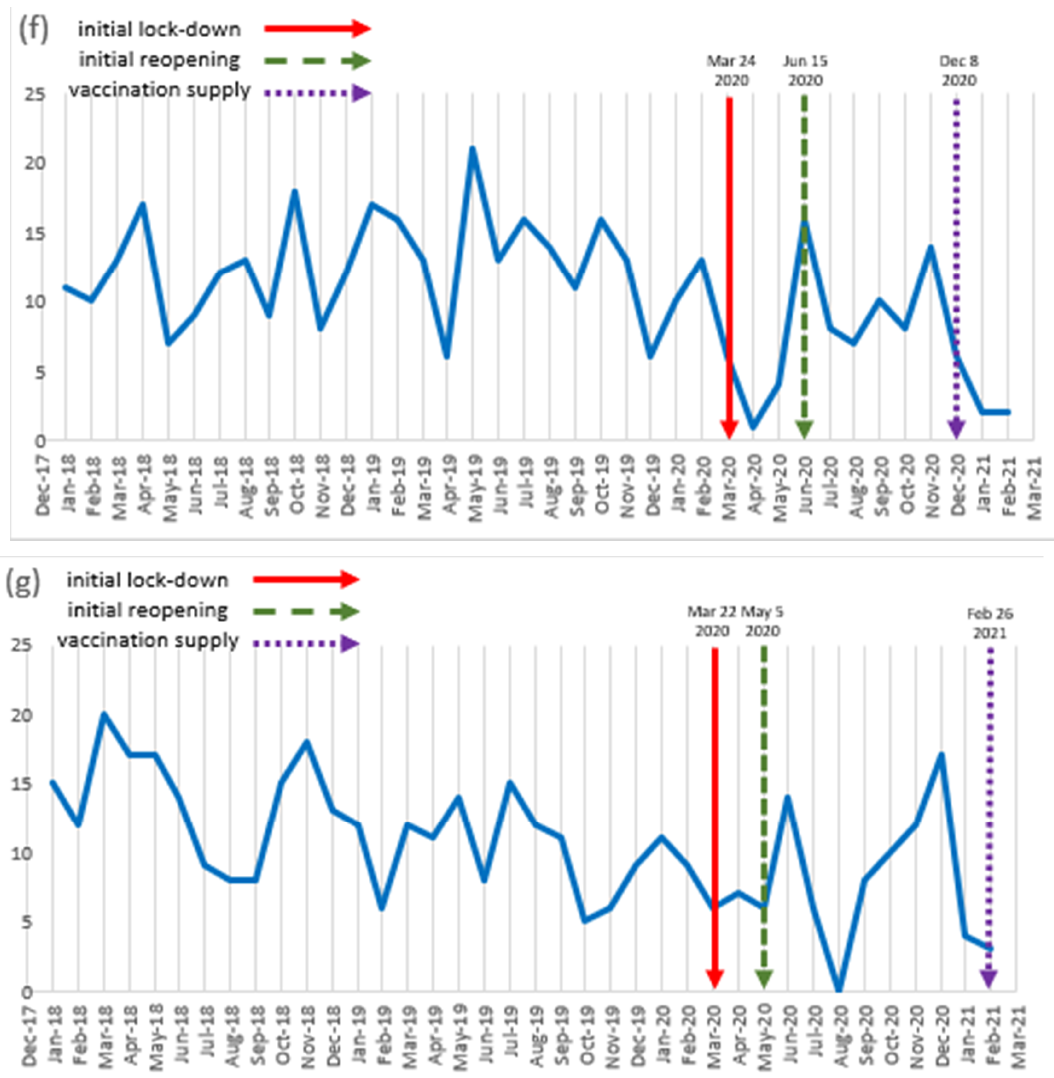
Figure 3. Monthly trends in the commencement of new oncology trials according to countries from 2018 to 2020. ( a ) United States; ( b ) China; ( c ) France; ( d ) Canada; ( e ) Italy; ( f ) United Kingdom; and ( g ) Korea.